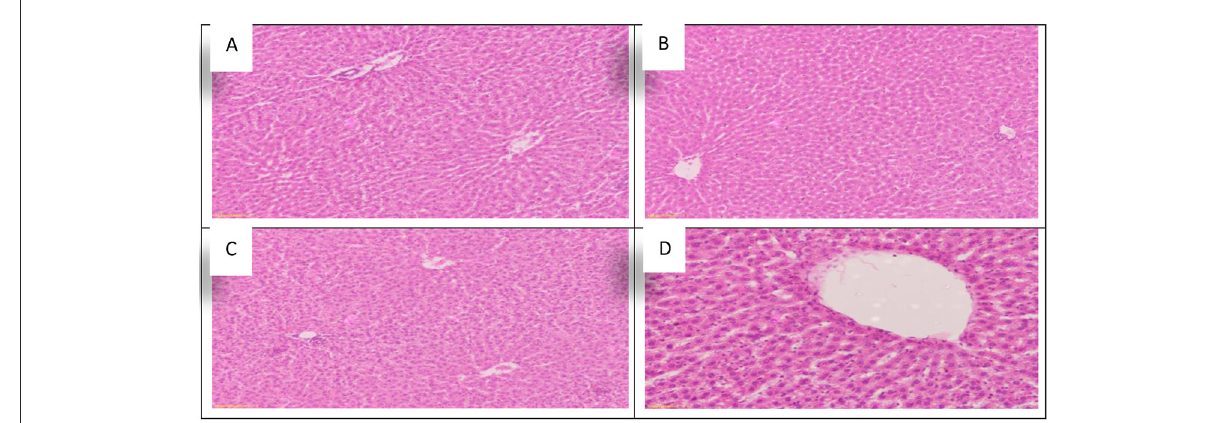
FIGURE5 Schematic diagram showing the effect of each aluminum, medicinal plant, and mix with aluminum and medicinal plants on histopathology of rats’ liver during return to normal after exposure to aluminum toxicity at 60 days after treatment. (A) Control group. (B) Allium sativum 5%. (C) Nigella sativa 5%, and (D) Allium sativum 2.5% + Nigella sativa 2.5%.